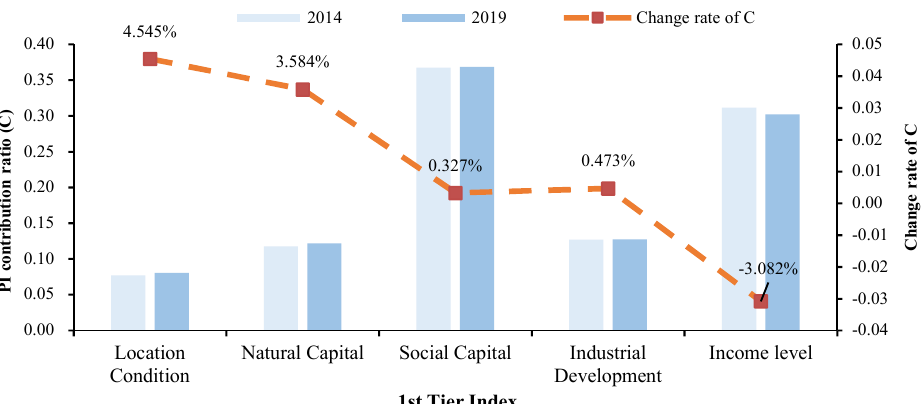
Figure 6. Analysis of the rate of change of poverty contribution according to the direction for 2014 and 2019.